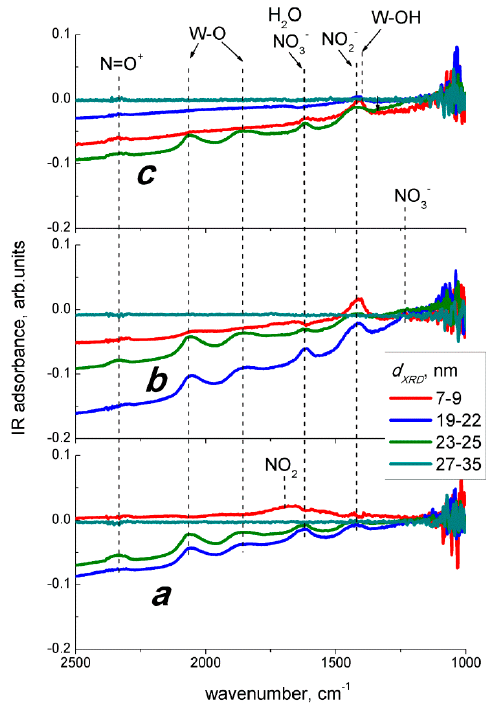
Figure 10. DRIFT spectra of WO 3 with different grain size exposed to 20 ppm NO in dry air at 25 °C ( a ), in dry air at 100 ° С ( b ), and in 90% r.h. humid air at 100 ° С ( c ).